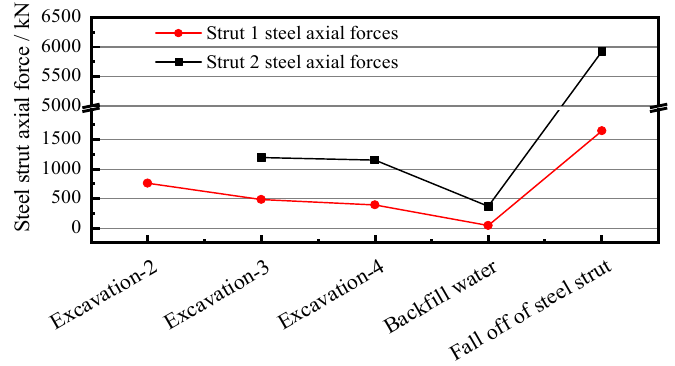
Figure 11. Time–history curve of the steel strut axial force.